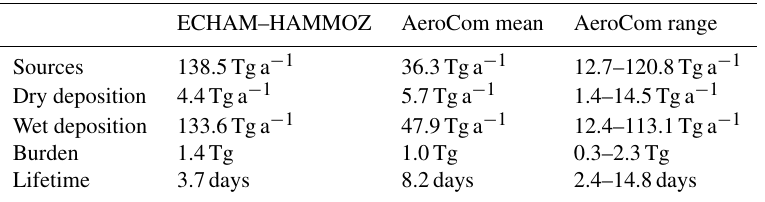
Table 4. Comparison of the ECHAM–HAMMOZ iSOA budget to total SOA budget terms from AeroCom (annual OA budget like in Fig. 1 in Tsigaridis et al., 2014; Kostas Tsigaridis, personal communication, 14 September